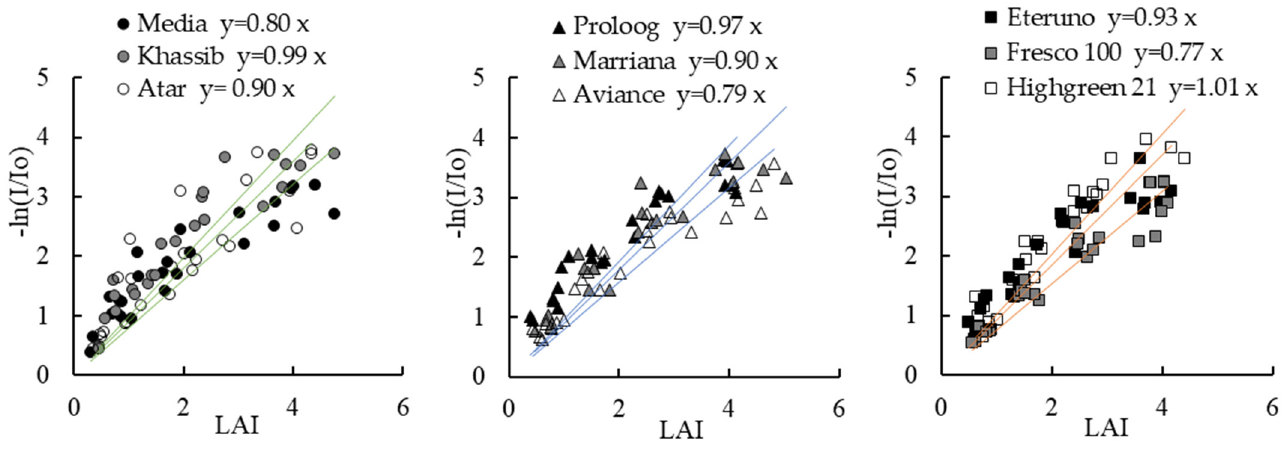
Figure 4. Extinction coefficient (k) in the nine cucumber cultivars.